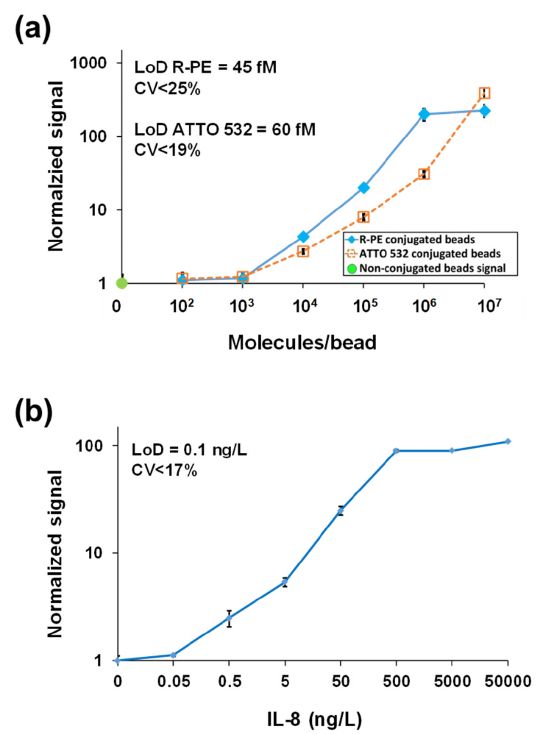
Figure 15. Dose-response experiments with the MAB system. ( a ) R-PE and ATTO 532 dose-response with M280SA magnetic beads. The calculated limit of detection (LoD) is 45 fM for R-PE and 60 fM for ATTO 532. ( b ) Recombinant human interleukin 8 (IL-8) dose-response (BioRad assay kit) in buffer. The calculated LoD is 0.1 ng/L. Reprinted from [15], with the permission of AIP Publishing 2019.